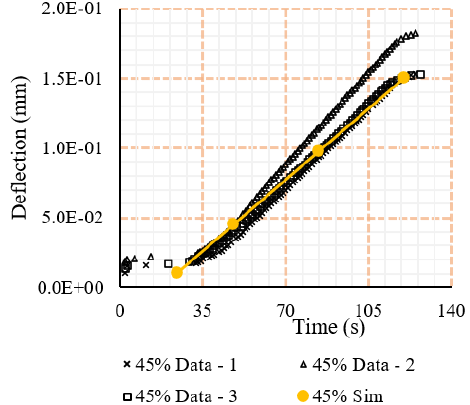
Figure 7. Elastic response comparison under 45% tensile loading (ratio of sustained load to the ultimate load) for trials and simulation.